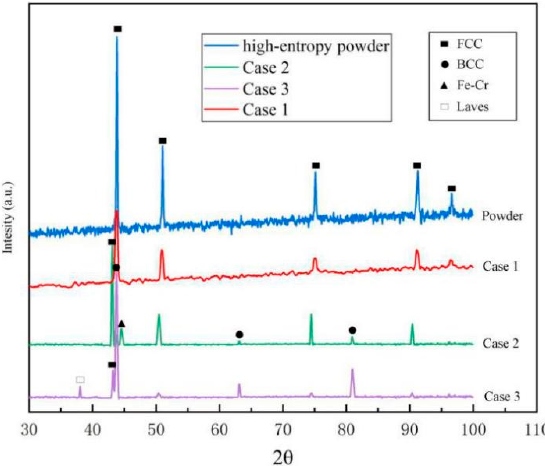
Figure 5. XRD patterns of as-alloyed powder and high entropy alloy (HEA) coatings.